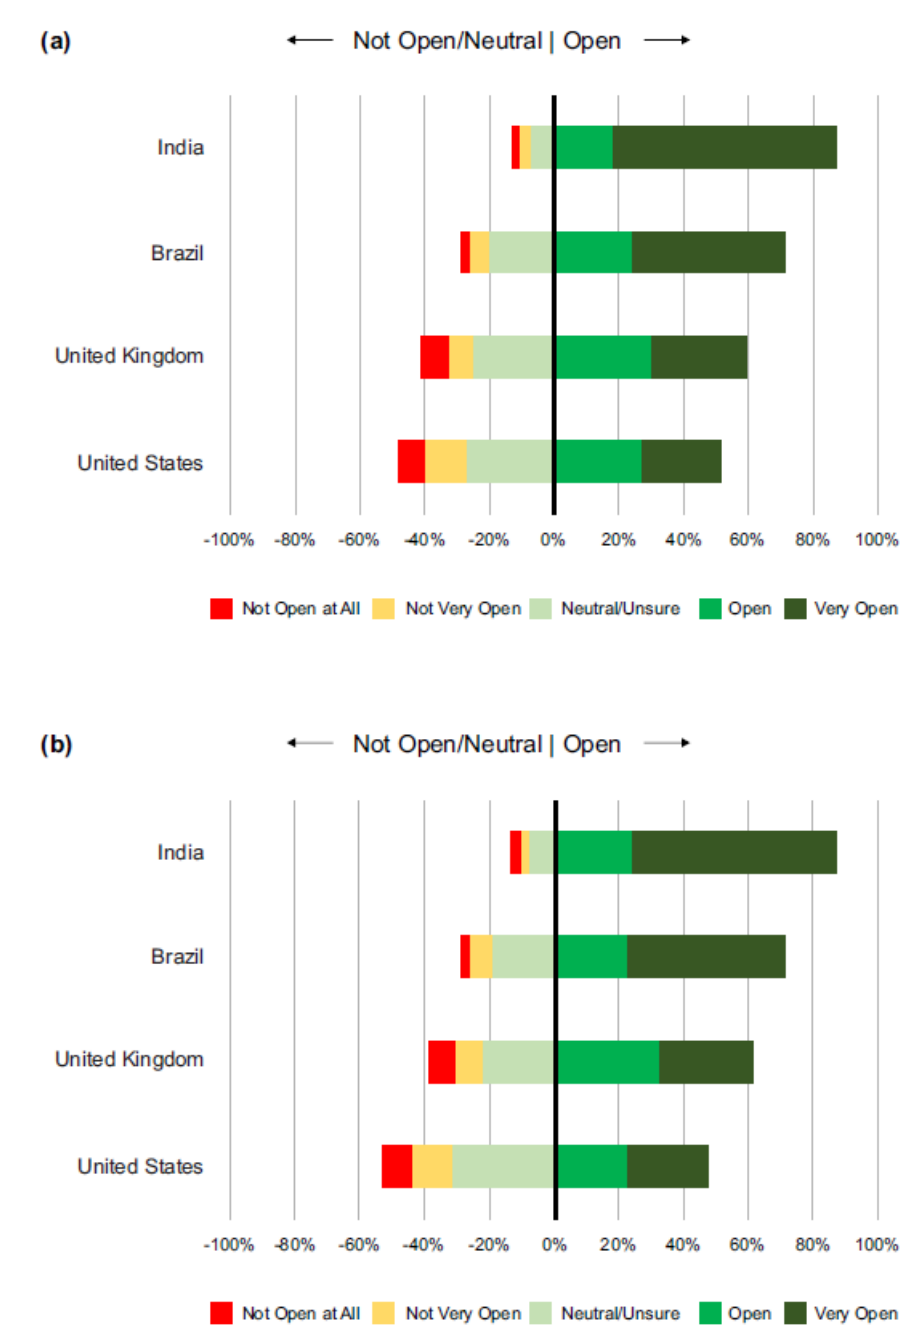
Figure 1. Openness for self ( a ) and children/other family members ( b ) to receive a COVID-19 vaccine, by country.